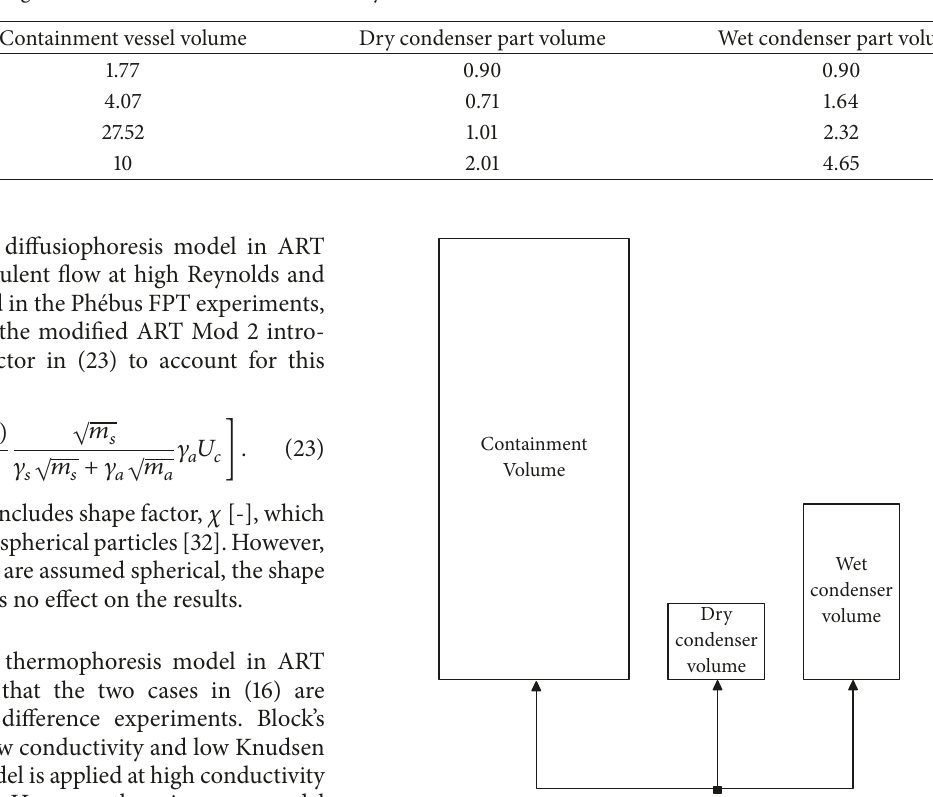
Table 8: Design conditions of containment vessel, dry condenser, and wet condenser in ART Mod 2.